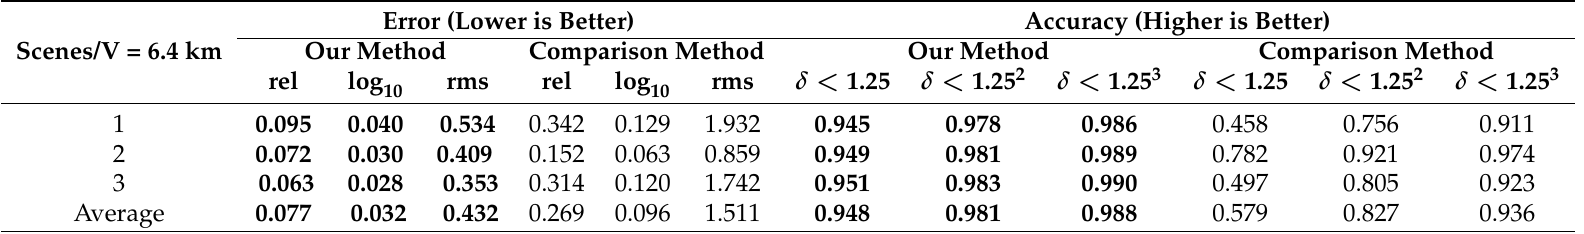
Table 3. Error and accuracy metrics of the second quantitative comparison method (V = 6.4